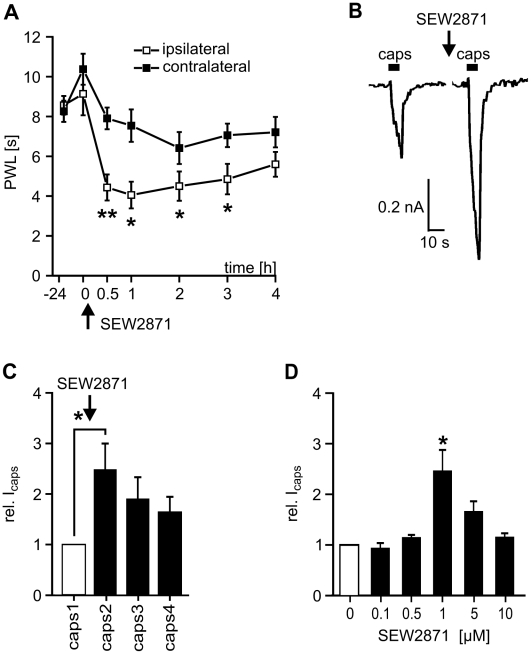
Significance of S1P1-mediated heat hypersensitivity.(A) Injection of the S1P1-selective agonist SEW2871 induced a significant reduction of PWL in C57BL/6J mice (100 µM, 5 µl, n = 8, *p<0.05, **p<0.01; ANOVA). (B) Conditioning stimulation of DRG neurons with the S1P1 agonist SEW2871 (1 µM) induced an increase in Icaps in an isolated DRG neuron. (C) SEW2871 (1 µM) significantly elevated average responses to consecutive capsaicin stimuli (1 to 4, 3 s at 120 s intervals) by a factor of 2.47±0.41 compared with control peak amplitudes (n = 6, *p<0.05; Wilcoxon matched pairs test). (D) Dose-response relationship of SEW2871 sensitization of Icaps. The ED50 was 0.56 µM and the maximum effect was observed with 1 µM SEW2871, the same concentration that gave the highest responses for S1P.